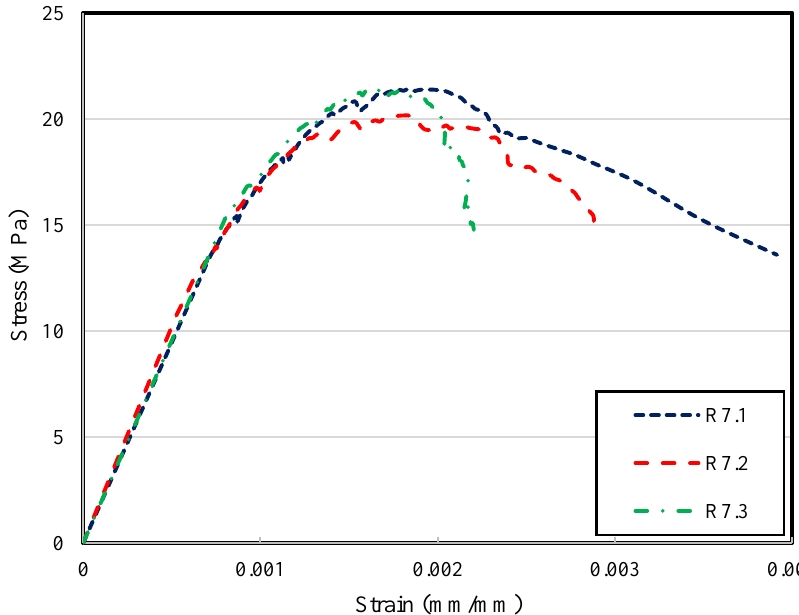
Figure 14. Stress-strain relationship of control specimens.